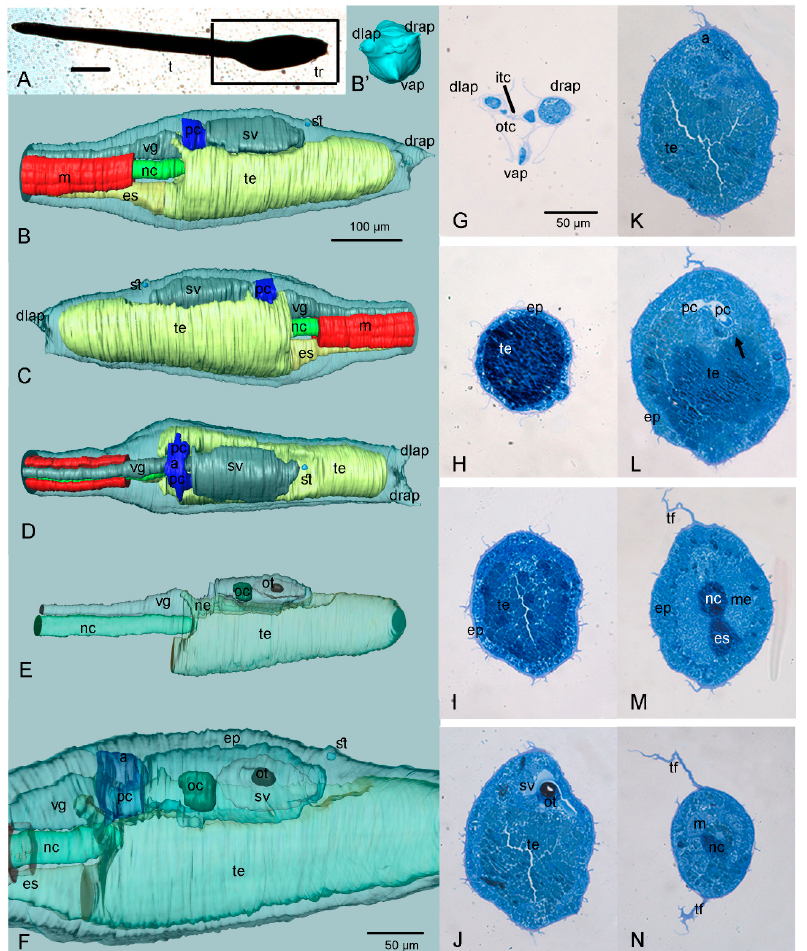
Figure 1. Anatomy of the larva of H. roretzi (see also the 3D-PDF of Figure S1; requires Acrobat Reader DC or higher). ( A ) Whole mount larva (in block of resin, contrasted with OsO 4 ). Right side view. t: tail; tr: trunk. The black square indicates the trunk region illustrated in ( B – E ). ( B – F ) Three-dimensional reconstructions. Colour code: blue, atrial chamber; dark green, ocellus; grey, nervous system; light green, notochord; red, muscles; yellow, endoderm (i.e., prospective pharynx). In B–D, the epidermis is transparent; in (E,F), the organs are transparent and their internal structures can be seen. ( B ) Right side view. ( B ′ ) Frontal view of the trunk showing the three papillae. ( C ) Left side view. ( D ) Dorsal view. ( E ) View of internal organs: trunk endoderm, nervous system and notochord. ( F ) Close view of the trunk region. ( G – N ) Some cross histological sections, from anterior to posterior, utilized for the 3D reconstruction. Toluidine blue. Arrow in L indicates the area where the protostigmata will open during metamorphosis. a: atrium; drap, dlap, vap: dorsal right-, dorsal left-, and ventral-adhesive papilla, respectively; ep: epidermis; es: endodermal strand; itc: inner tunic compartment; m: muscle; me: mesenchyme; nc: notochord; ne: neck; otc: outer tunic compartment; pc: peribranchial chambers; oc: ocellus; ot: otolith; st: stomodeum (i.e., oral siphon primordium); sv: sensory vesicle; te: trunk endoderm; tf: tail fin; vg, visceral ganglion. The enlargement is the same in ( B – E ) and in ( G – N